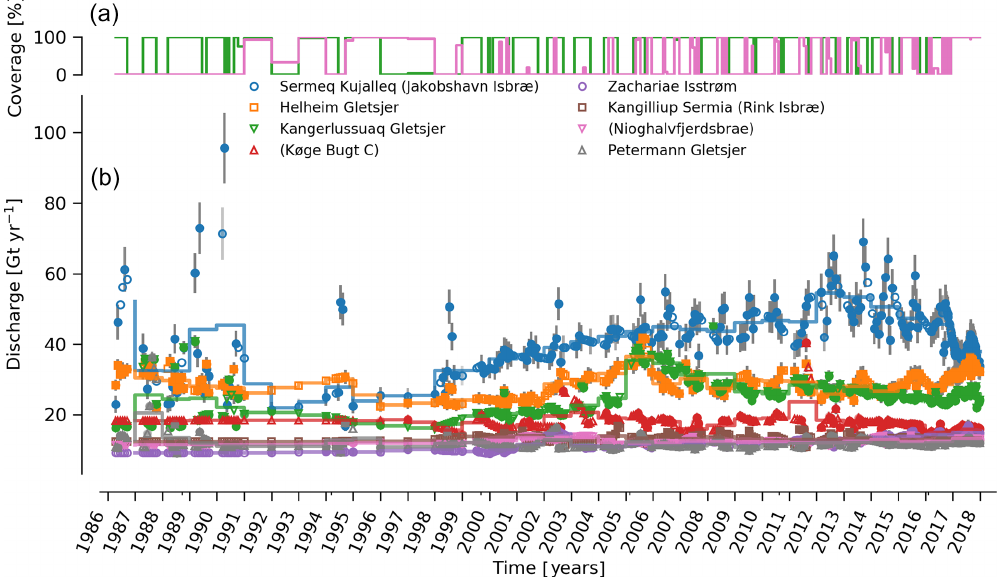
Figure A5. Same as Fig. 6 but without the velocity filter. Note the different y axis.